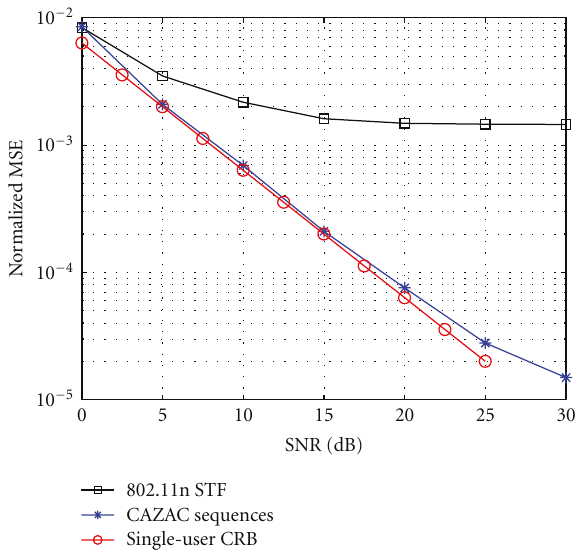
Figure 2: MSE of CFO estimation using N = 32 Chu sequences and IEEE 802.11n STF for uniform power delay profile.